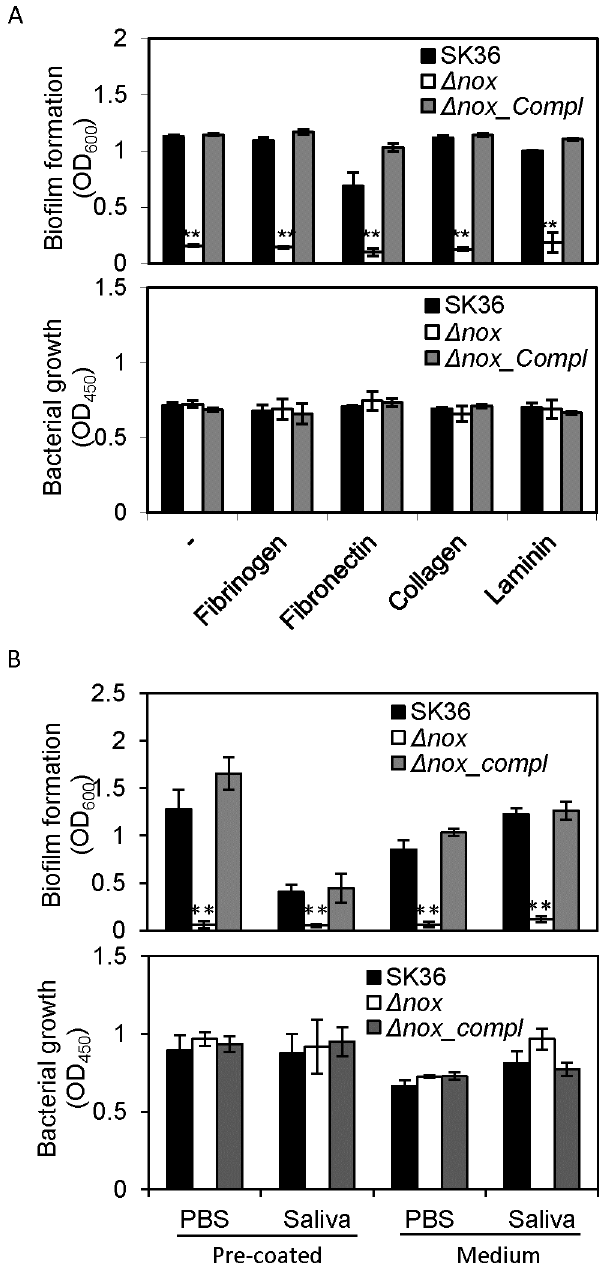
Fig 2. Decrease in biofilm formation of the nox mutant with human plasma, extracellular matrix proteins and saliva. A, biofilm formation (OD 600 ) and growth (OD 450 ) in BM on plate wells pre-coated with human plasma and extracellular matrix proteins. B, biofilm formation (OD 600 ) in BM on plate wells pre-coated with human saliva (pre-coated) and in BM medium mixed with saliva (medium). (OD 450 ), growth in BM (pre- coated) or BM mixed with saliva (medium). Δ nox , the nox mutant; Δ nox_compl , the complemented strain of the nox mutant. ** , significant difference with P < 0.01 compared to SK36. Data obtained at least in